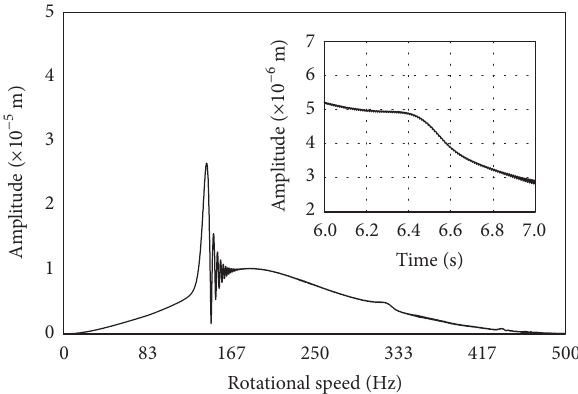
Figure 11: Total displacement at node 21 of the rotor-bearing system fortheradialclearanceofthesqueezefilmdamperequalto0.08 mm.